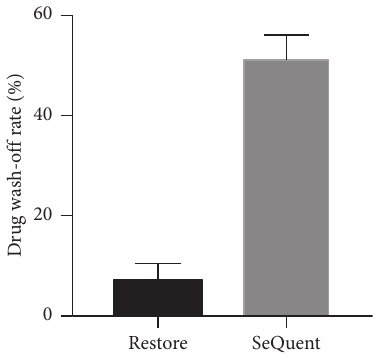
Figure 2: Results of quantitative analysis of drug wash-off rate. Drug wash-off rate of the Restore ® group was substantially lower than that of the SeQuent ® Please group (7% ± 6% versus 51% ± 9%, p < 0 .